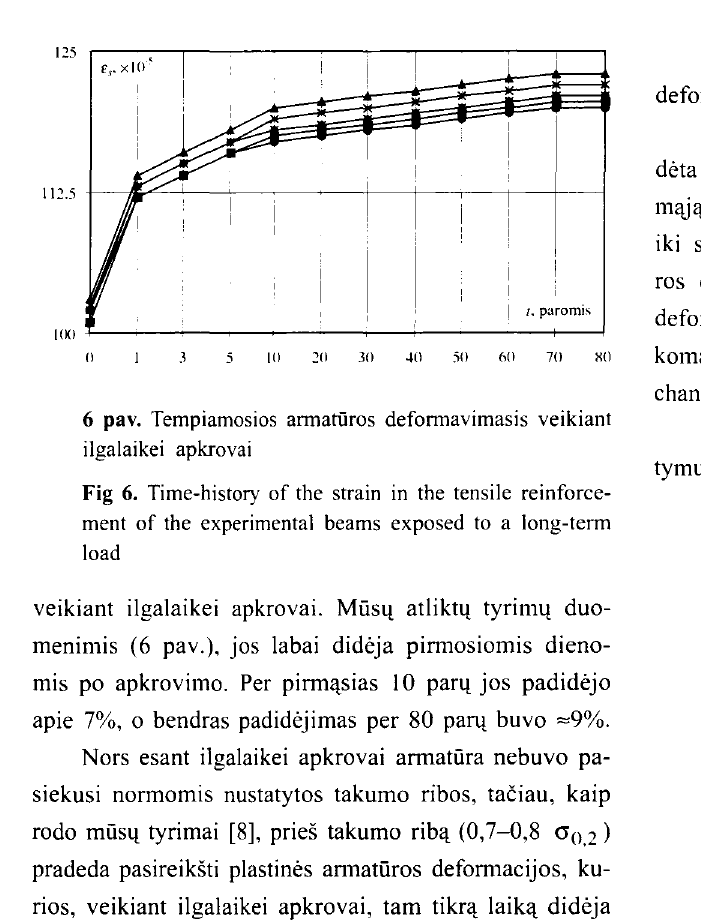
Fig 7. Deflections of the strengthened beams measured up to bending failure during the application of short -term loads: I - beams Sl-1, SI-2 (0.85 Mu ); 2 -